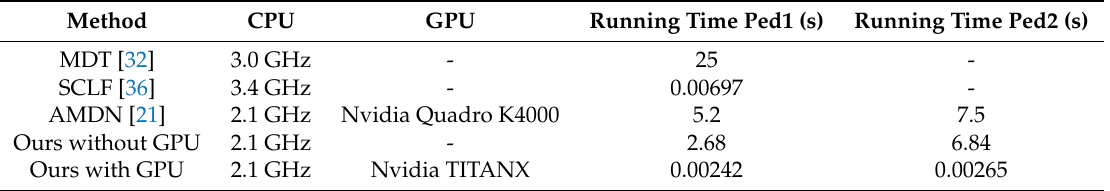
Table 3. Comparison of different methods in terms of running time (seconds per